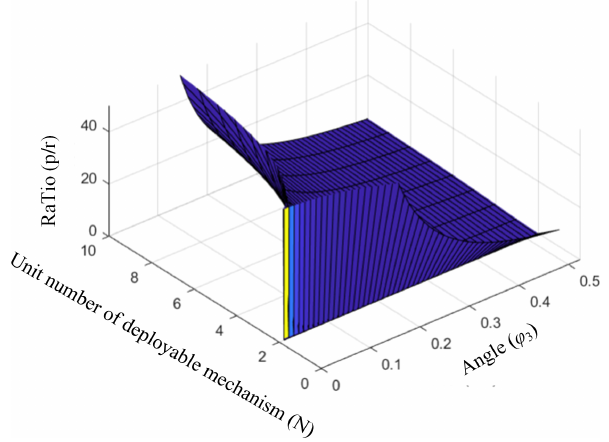
Figure 7. Three-dimensional diagram of the proportional scissor rod